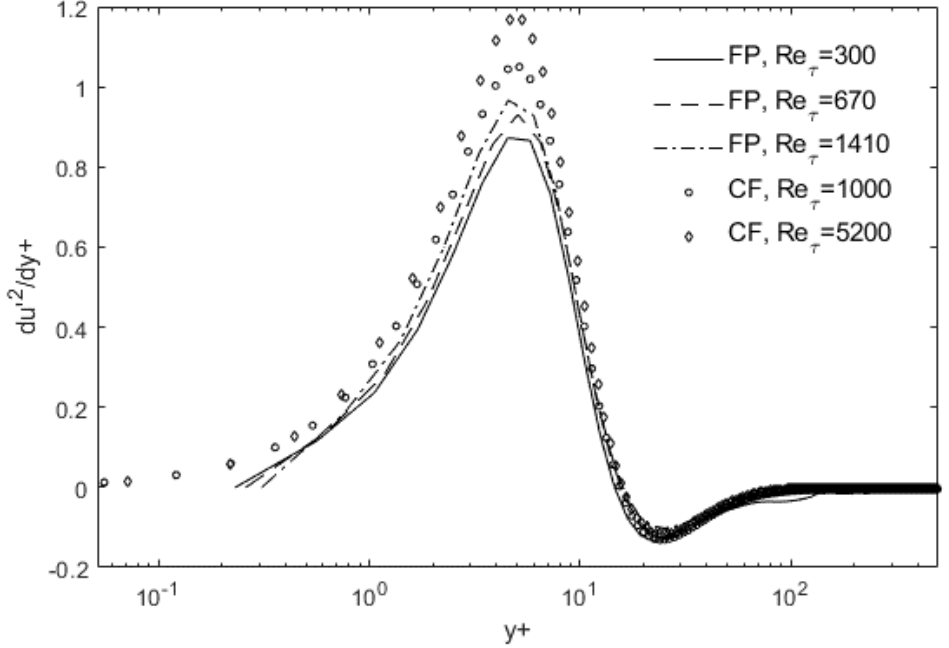
Figure 2. Combined scaling of du’ 2 /dy+ for flat-plate (FP) and channel flows (CF). The near-wall peaks increase, while the negative undulations reduce in magnitude with increasing Reynolds number. DNS data of Spalart [13] for FP and Graham et al. [12] for CF are used.